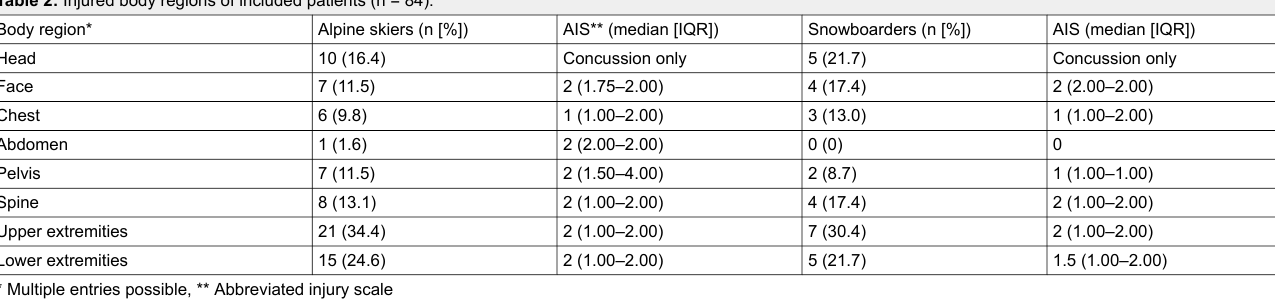
Table 3: Comparison of protective equipment wearing rates between the 2007/2008 and 2008/2009 seasons (n = 84). Type of protective equipment